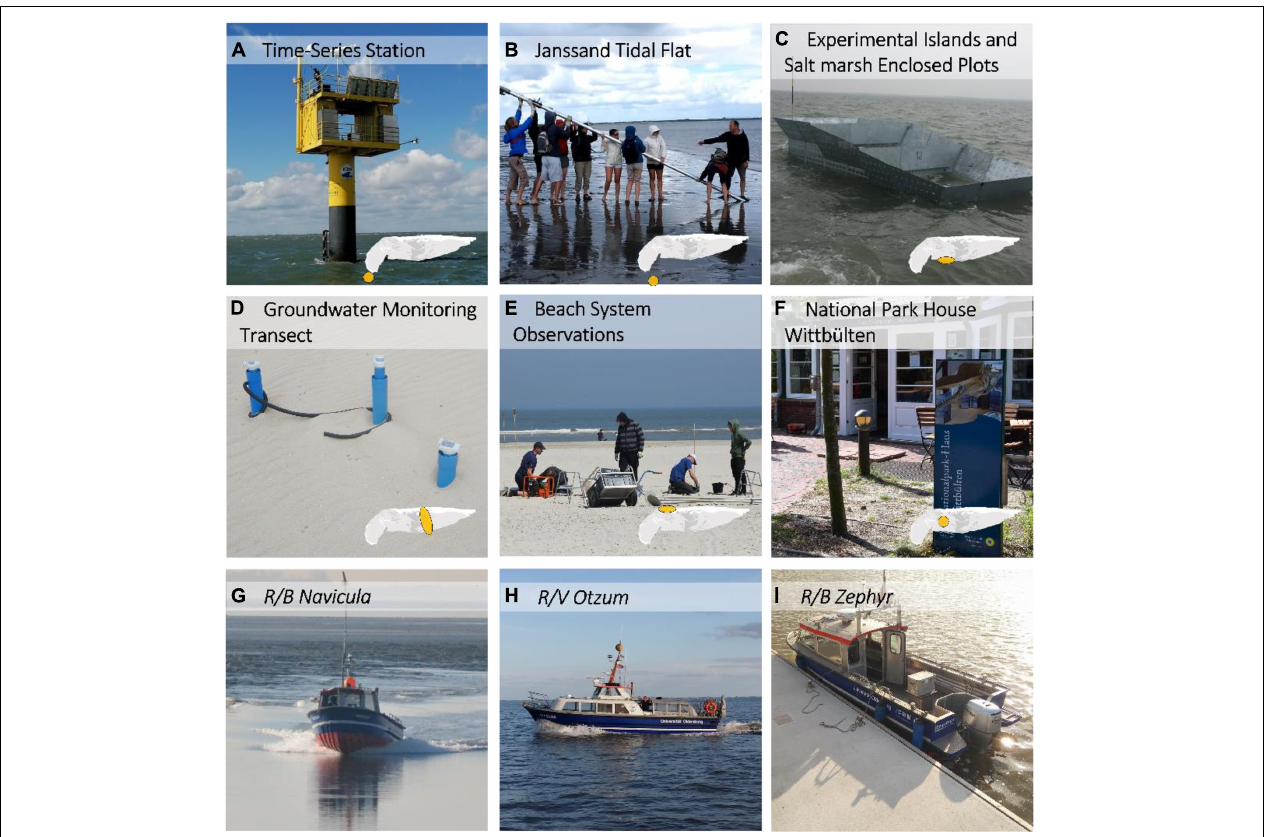
FIGURE 4 | SCO infrastructure and elements. Several components are available supporting the Spiekeroog Coastal Observatory . The ICBM operates the Time-Series Station Spiekeroog, a permanent monitoring station southwest of Spiekeroog (A) . The Janssand (B) and North Beach (E) serve as campaign-based research sites for biogeochemical observations. Experimental islands were built within the back barrier tidal flats and corresponding salt marsh enclosed plots in the South for metacommunity and biodiversity research (C) . Dip wells were installed on a transect for groundwater monitoring (D) . As an accommodation for scientists as well as a communications platform serves the National Park House Wittbülten (F) . Three different research boats are available supporting any kind of research activities of the SCO (G–I)